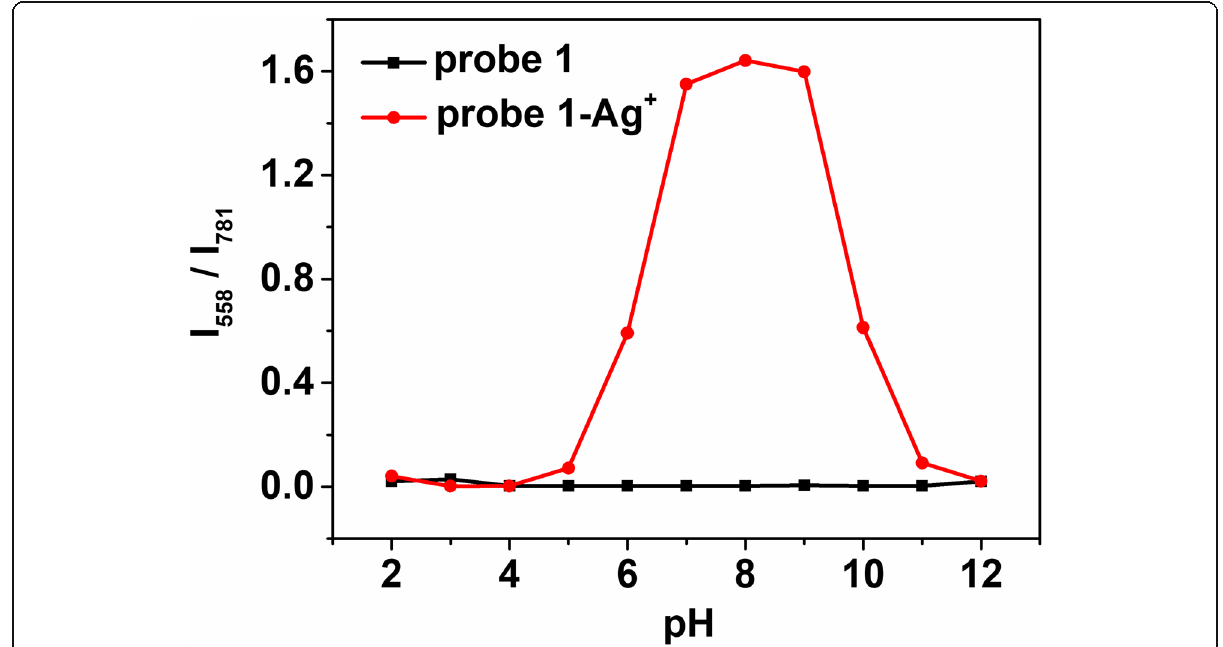
Fig. 8 Effect of pH on the fluorescence intensity ratio (I 558 /I 781 ) of probe 1 (black line) and 1 + Ag + (red